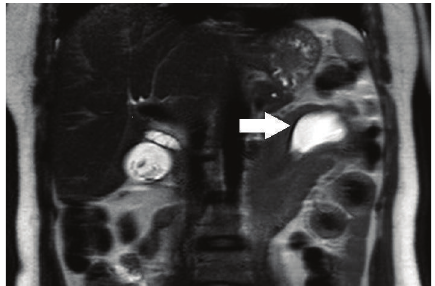
Figure 3: Coronal T2 weighted single-shot turbo spin echo RM image confirms the cyst (arrow) as the cause of intussusception and biliary dilatation.